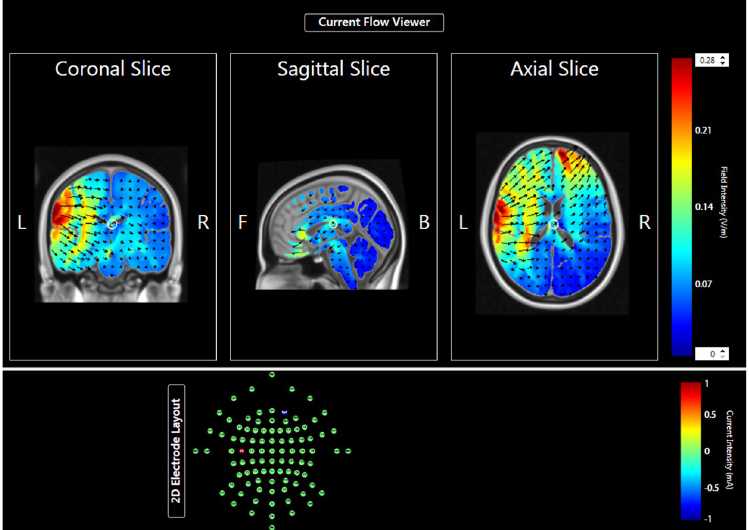
Fig 2. Computer modeling of the current distribution for C5-FP2 montage used in the current study.